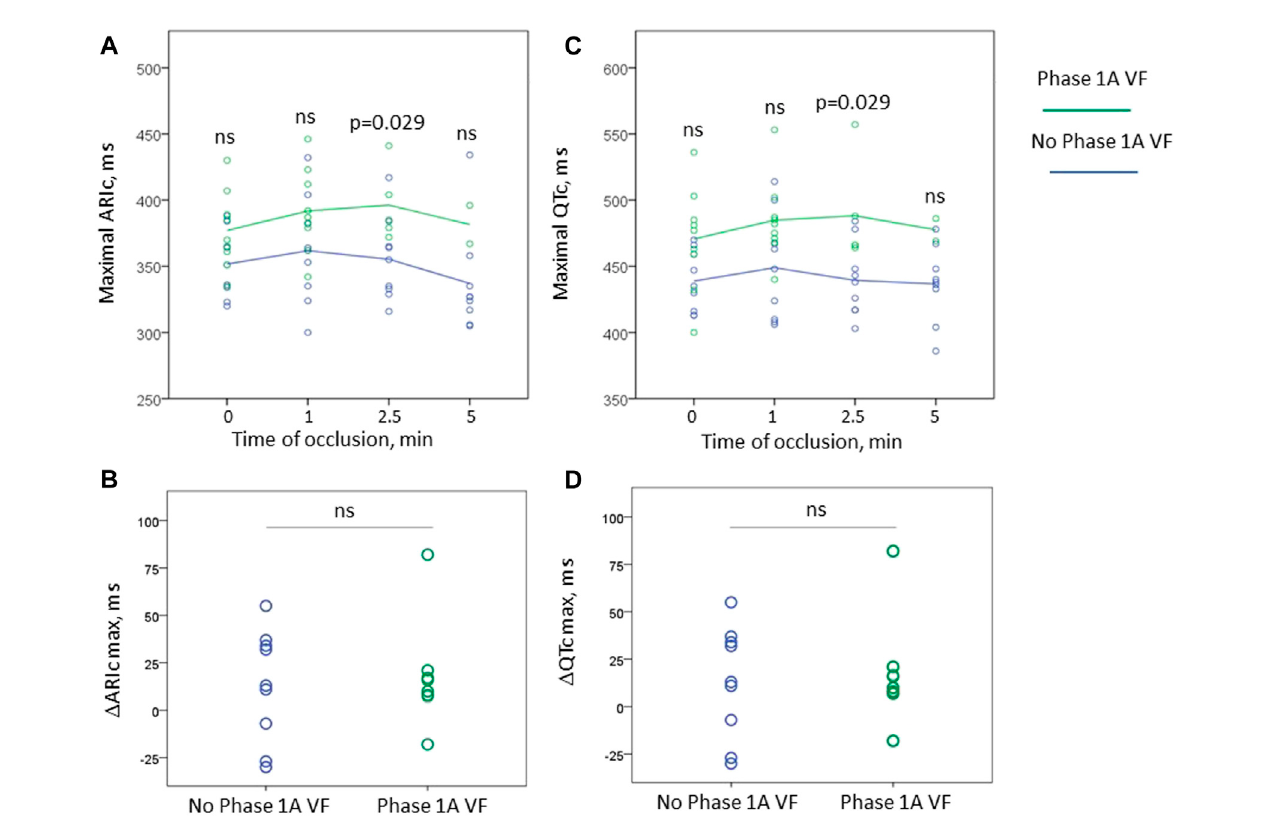
FIGURE 4 Changes of maximal ARIc (panels (A,B) ) and maximal QTc intervals (panels (C,D) ) during fi rst 5 min of occlusion in the animals experiencing phase 1A VF ( n = 9 at baseline) and no phase 1A VF ( n = 9). Panels (A, C) display absolute values of ARIc and QTc, respectively, plotted vs. time of occlusion. Panels (B, D) show the magnitude of maximal change of these variables in respect to baseline. See that only one animal experiencing VF demonstrated shortening of repolarization (negative values in panels (B, D) ). However, no statistically signi fi cant differences between the groups were found in the baseline absolute values and the magnitude of the changes. The only signi fi cant difference between VF-resistant and susceptible animals were the absolute values of ARIc and QTc durations at 2.5 min after occlusion onset. ns, non-signi fi cant.